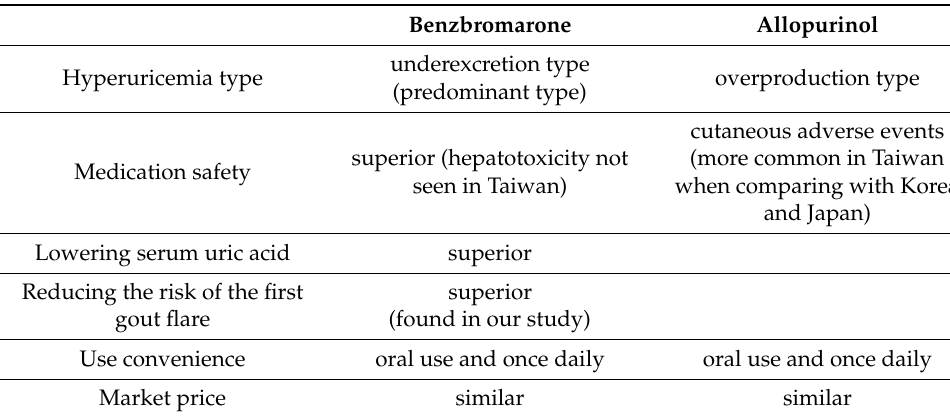
Table 5. Comparison between benzbromarone use and allopurinol